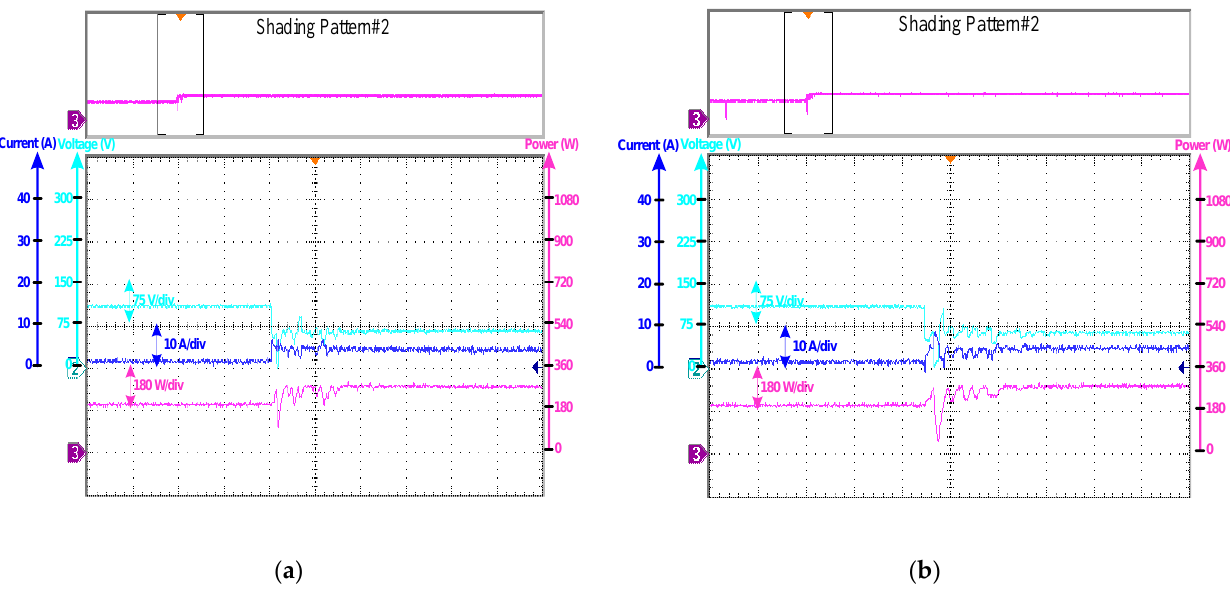
Figure 10. Experimental results of output power and voltage of the uniform pattern (SP#1) using: